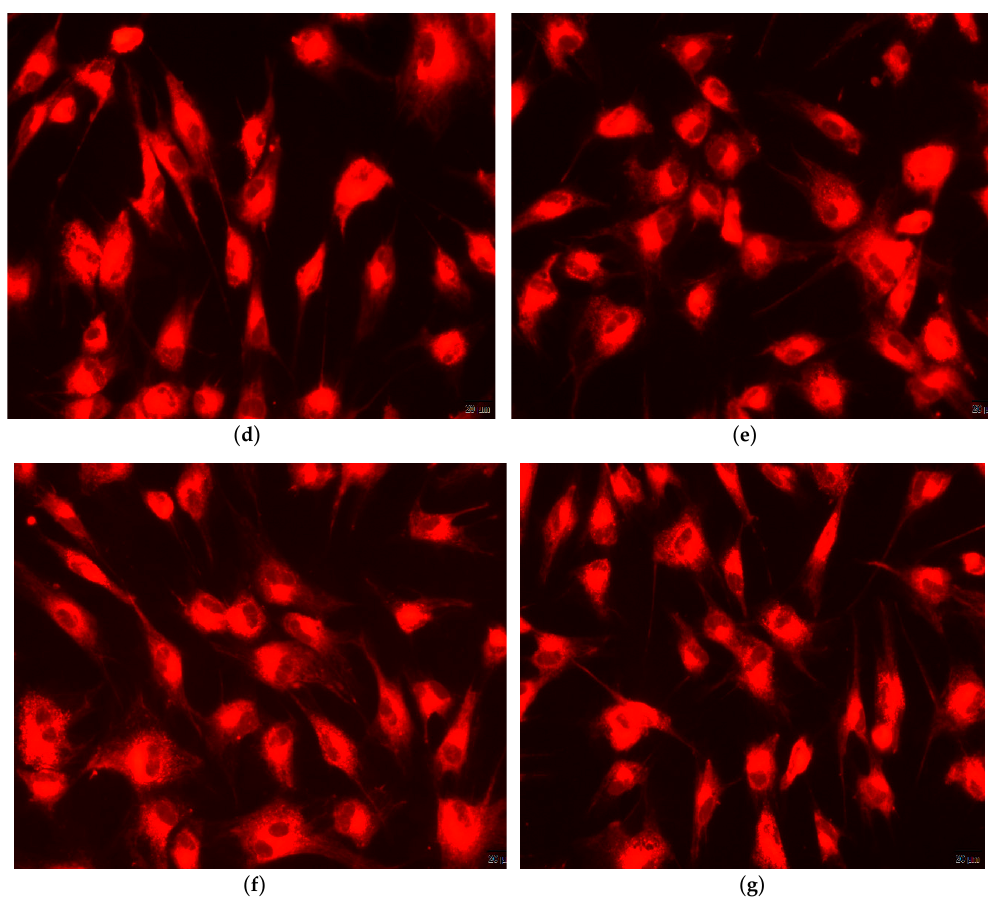
Figure 11. Fluorescence images of Eu X HAp samples coloured with CMTPX fluorophore ( a ) Control sample, ( b ) Eu0.5HAp, ( c ) Eu1HAp, ( d ) Eu1.5HAp, ( e ) Eu2HAp, ( f ) Eu10HAp, ( g ) Eu50HAp.